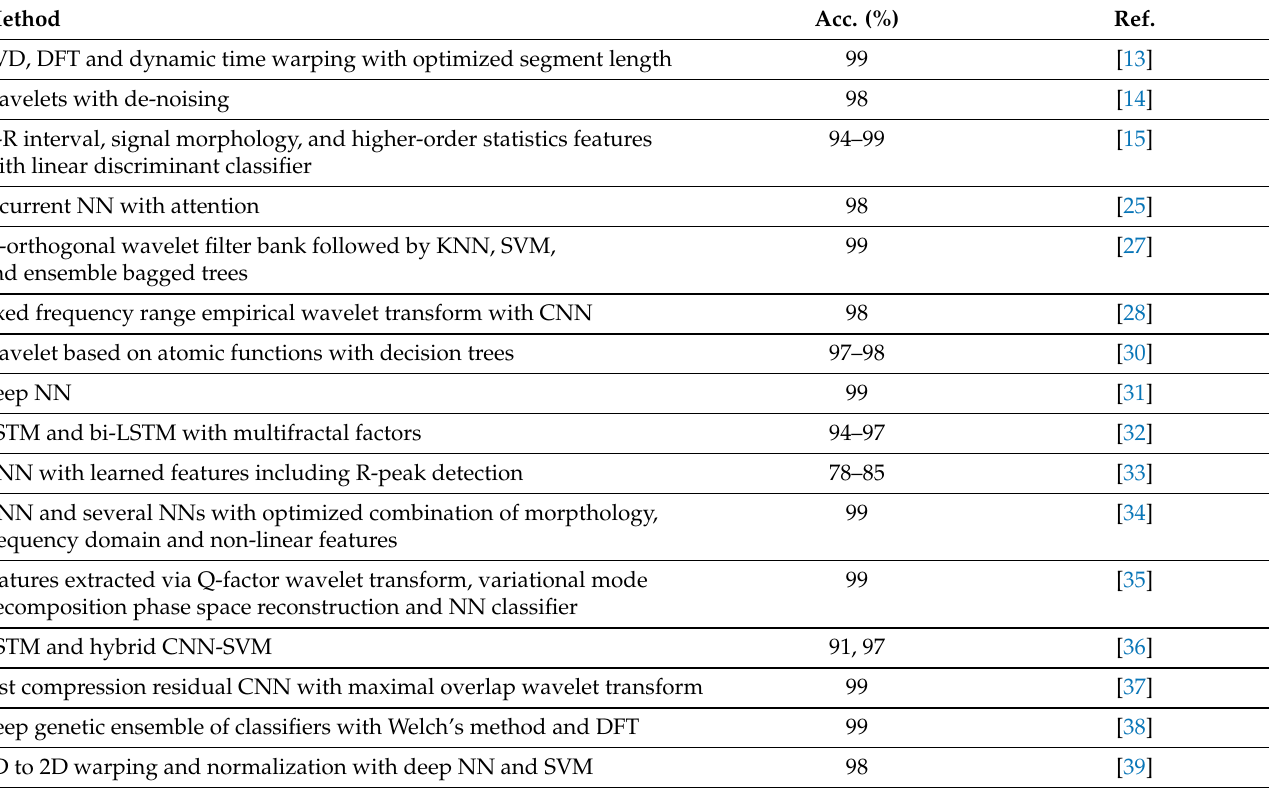
Table 4. The state-of-the-art techniques for classifying ECG